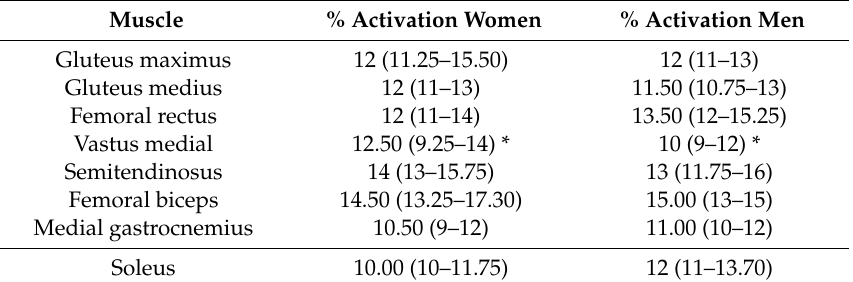
Table 4. Statistics and significance of the percentage of total muscle activation during the running cycle